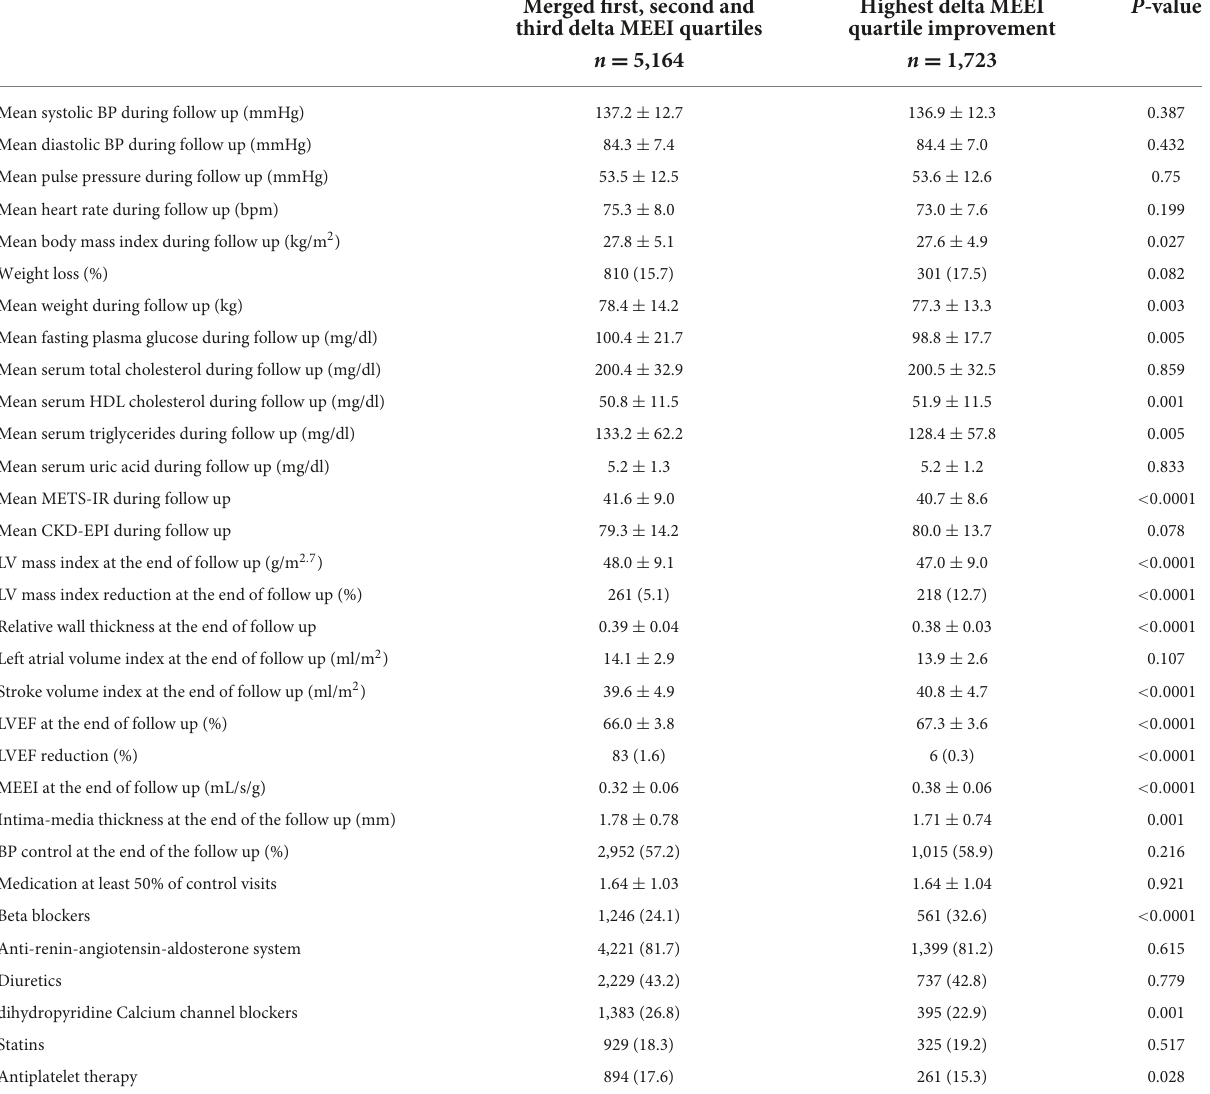
TABLE 2 Follow-up data and